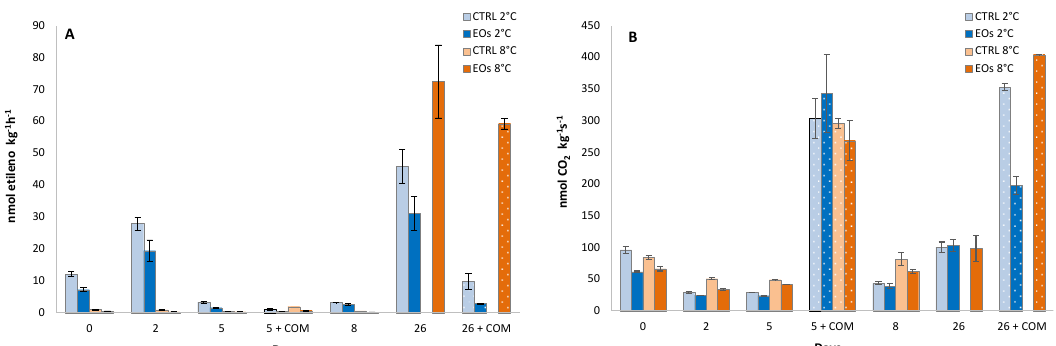
Figure 1. Ethylene production ( A ) and CO 2 production ( B ) during cold storage periods (2 and 8 °C) and complimentary commercialization simulations (COM; 4 days at 22 °C) for flat peach samples with or without active paper sheets (including β cyclodextrin (CD)-encapsulated essential oils (EOs)) ( n = 3 ± SD).